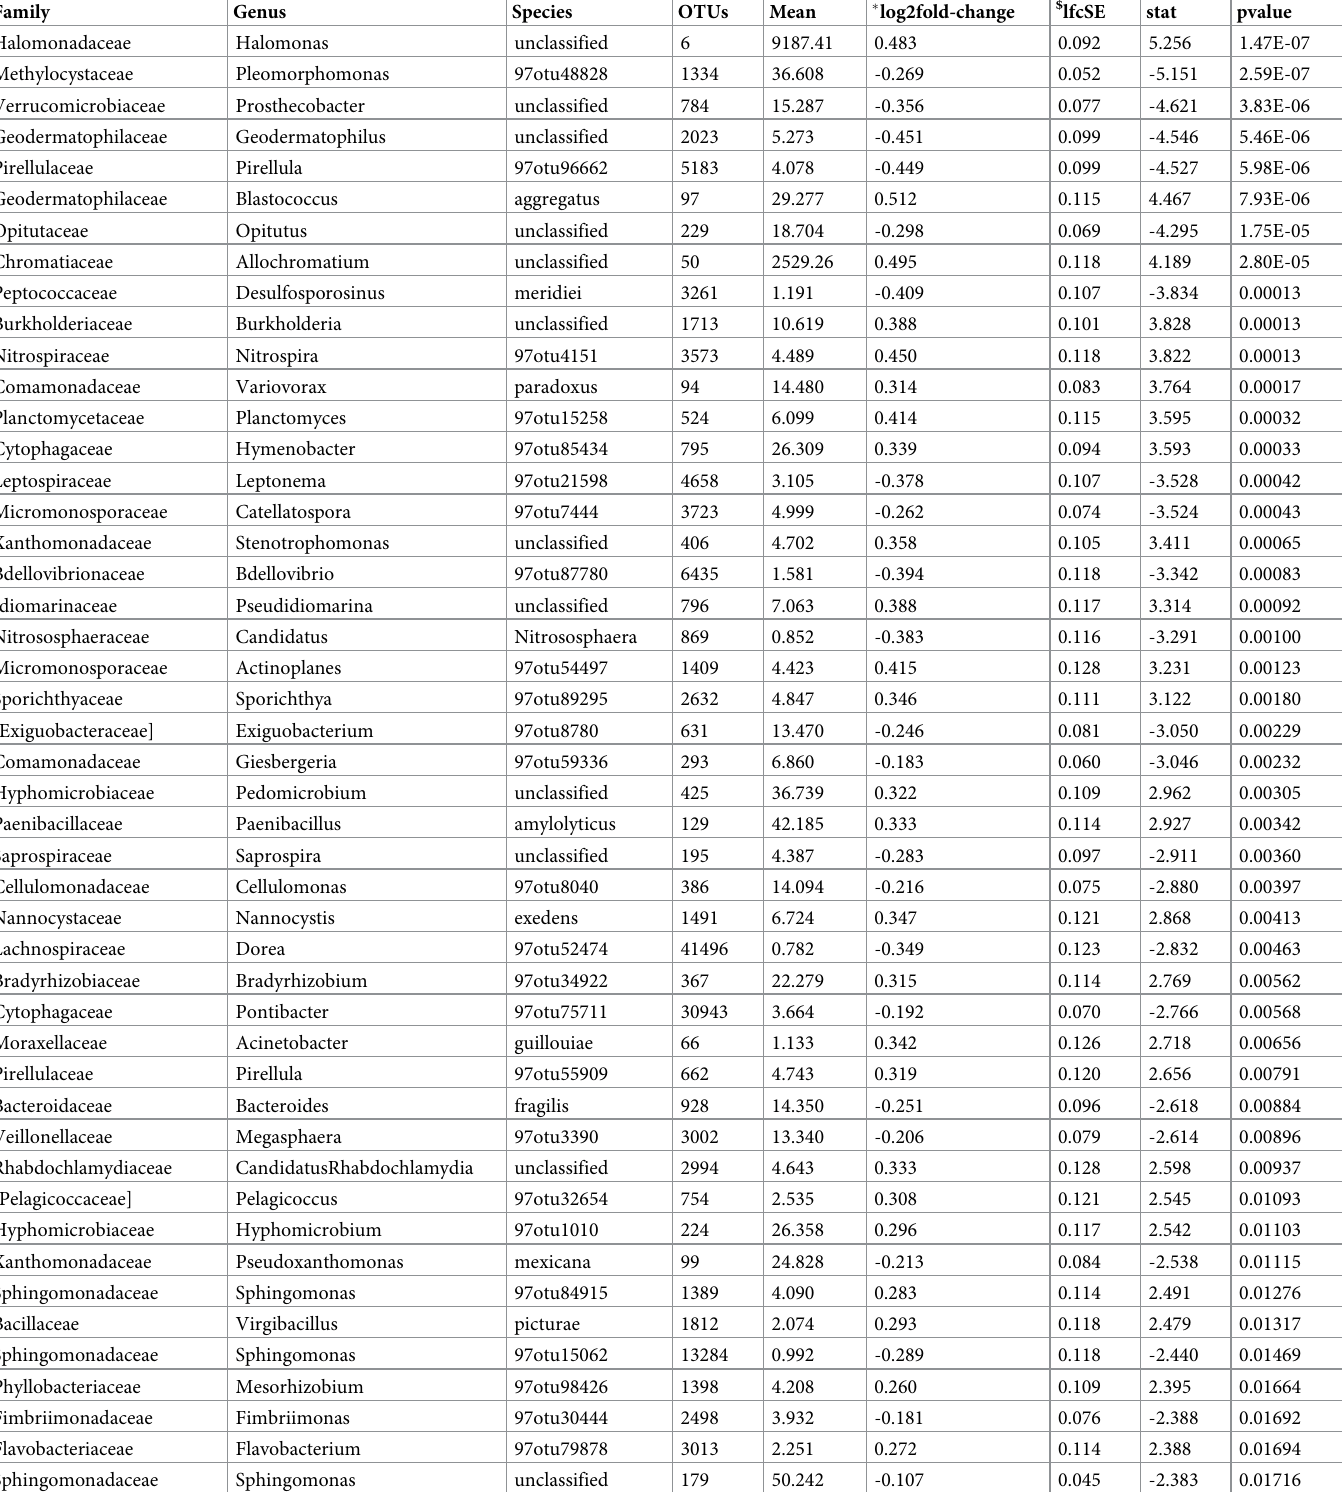
Table 5. Effect of season on bacterial species during the three growing